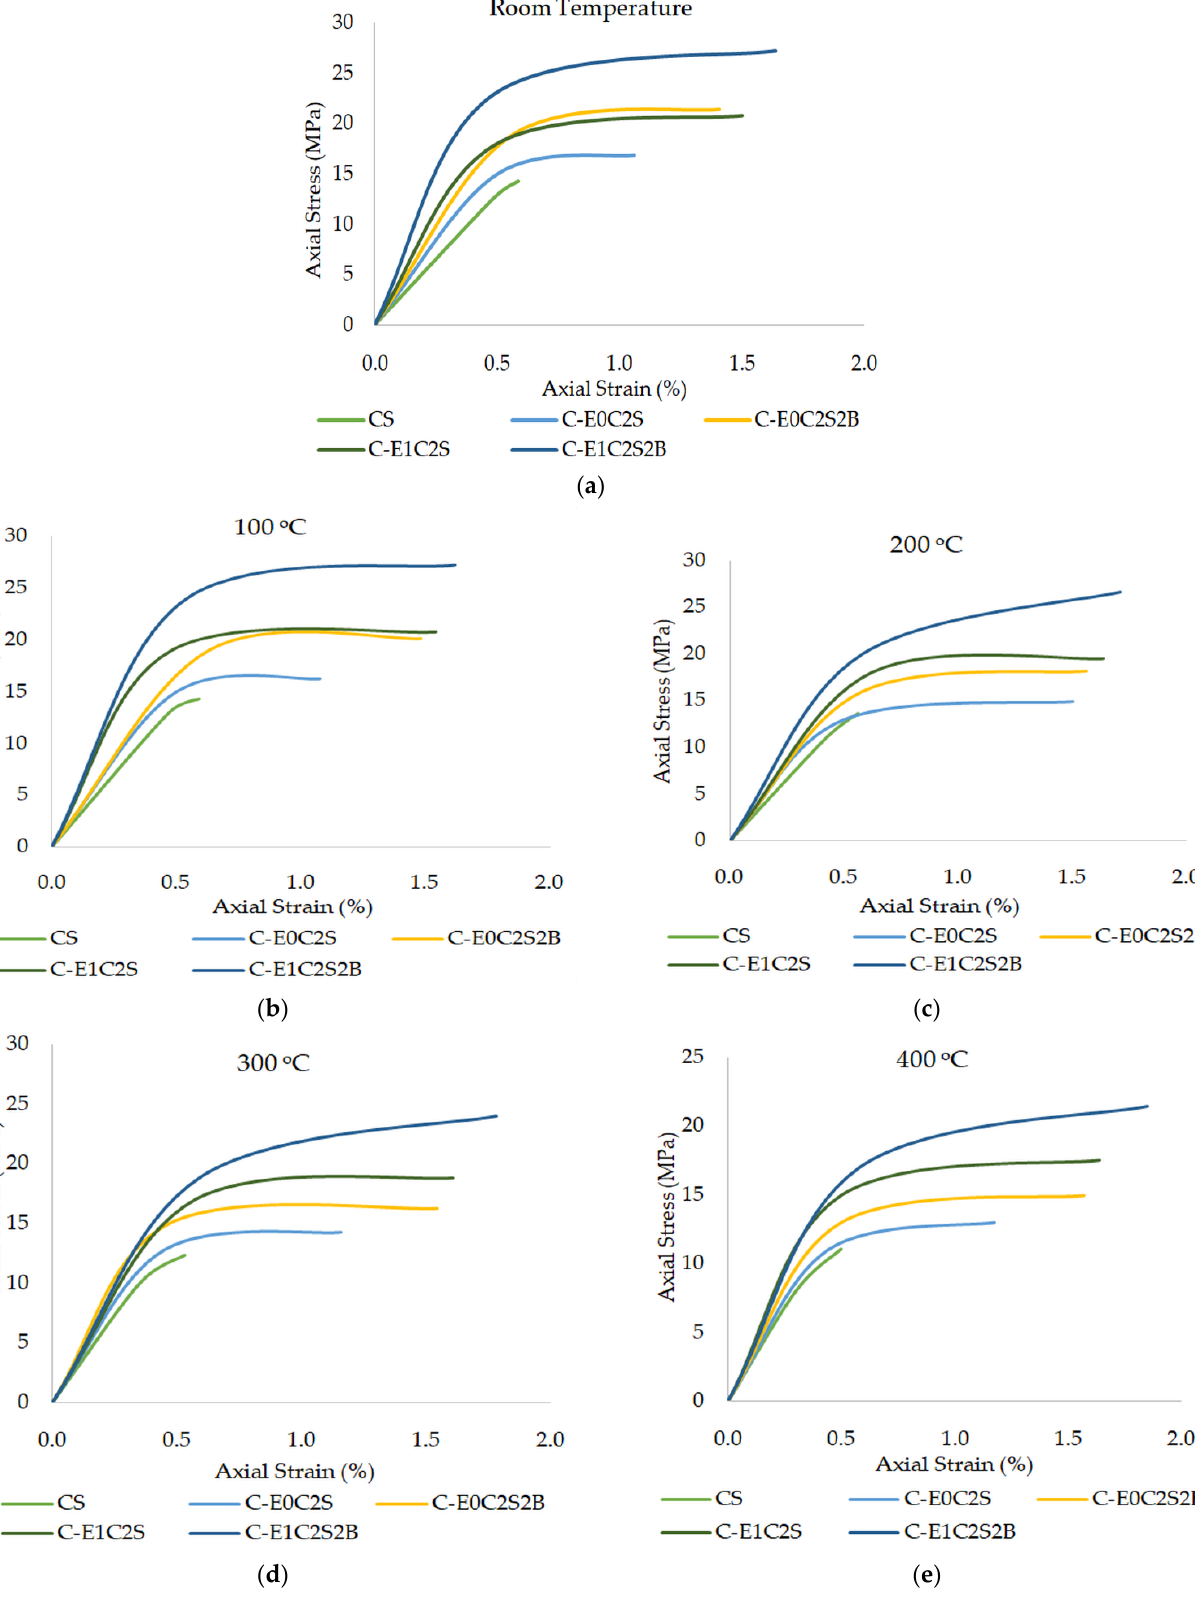
Figure 12. Axial stress–strain curves of cylinders exposed to different temperature regimes: ( a ) room temperature; ( b )100 °C; ( c ) 200 °C; ( d ) 300 °C; and ( e ) 400 °C.